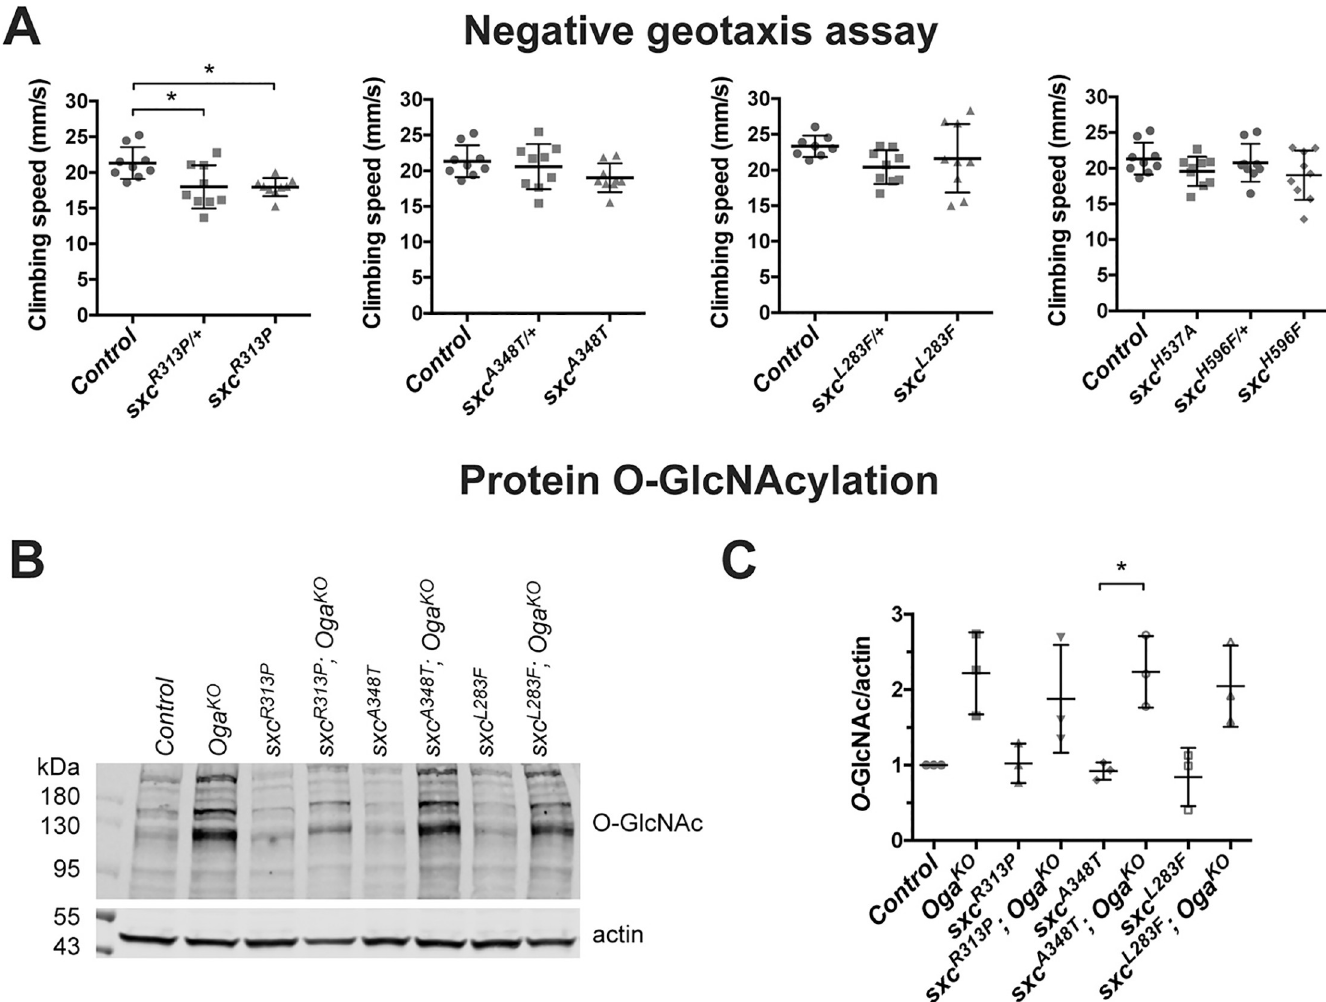
Fig 3. Locomotor and biochemical characterization of sxc R313P , sxc A348T and sxc L283F flies. (A) Climbing locomotor behaviour was assessed based on the climbing speed (mm/s) in an automated negative geotaxis assay. The sxc R313P/+ and sxc R313P (N = 9) flies showed reduced climbing speed compared to background control (N = 9) indicating locomotor dysfunction. sxc A348T , sxc L283F , sxc H537A and sxc H596F flies (N = 9 for all genotypes) did not show significantly reduced climbing speed. Data presented as mean ± SD. � p adj < 0.05 based on one-way ANOVA with Tukey’s multiple comparisons of mean climbing speed. A complete list of p-values and summary statistics is provided in S3 Table . (B) Western blot on head samples from 1–4 days old male adult Drosophila indicate no significant alteration in the level of protein O-GlcNAcylation in sxc R313P , sxc A348T and sxc L283F samples compared to the genetic background controls, while the homozygous Oga KO allele caused an increase of O-GlcNAcylation. Western blot was probed with a monoclonal anti-O-GlcNAc antibody (RL2). (C) Quantification of O-GlcNAcylated proteins revealed that protein O-GlcNAcylation in sxc R313P , sxc A348T and sxc L283F flies remain at a similar level as in the control samples. Data presented as mean ± SD. � p adj = 0.035, based on one- way ANOVA with Tukey’s multiple comparisons test, n = 3 for all lines. A complete list of p-values and summary statistics is provided in S3 Table